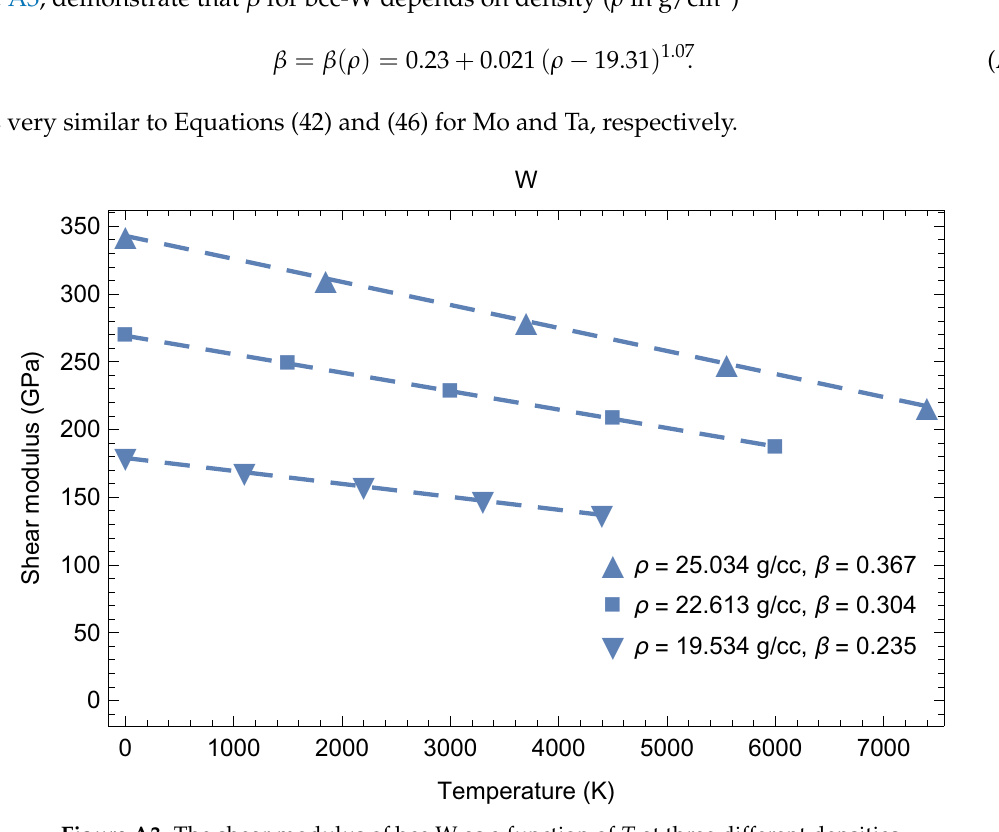
Figure A3. The shear modulus of bcc-W as a function of T at three different densities. The longitudinal and bulk sound velocities in bcc-W along its principal Hugoniot are shown in Figure A4 along with the corresponding experimental data from